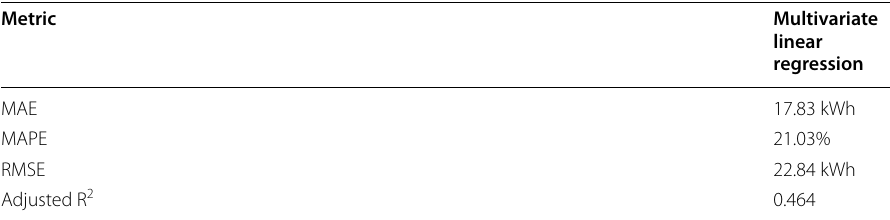
Table 2 Baseline performance